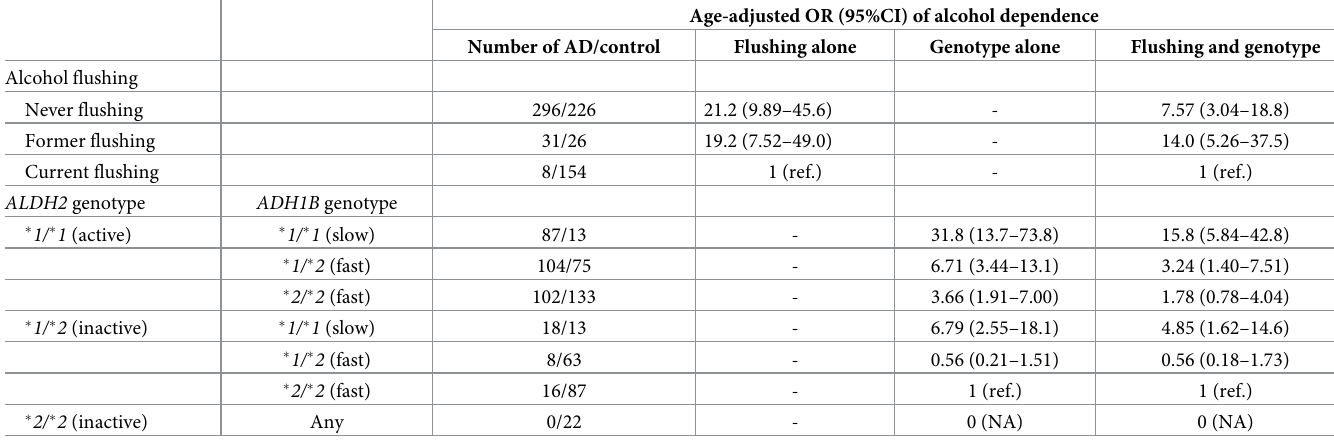
Table 3. Age-adjusted odds ratios (95% confidence intervals) of alcohol dependence according to alcohol flushing status and/or the combinations of ALDH2 and ADH1B genotypes in the female